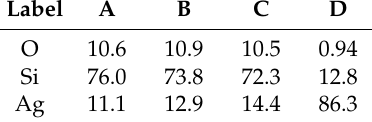
Figure 6. TEM images of EDX position on the surface of Ag-EDTA-SBA-15. Table 2. EDX analysis of the Ag-EDTA-SBA-15 composites.